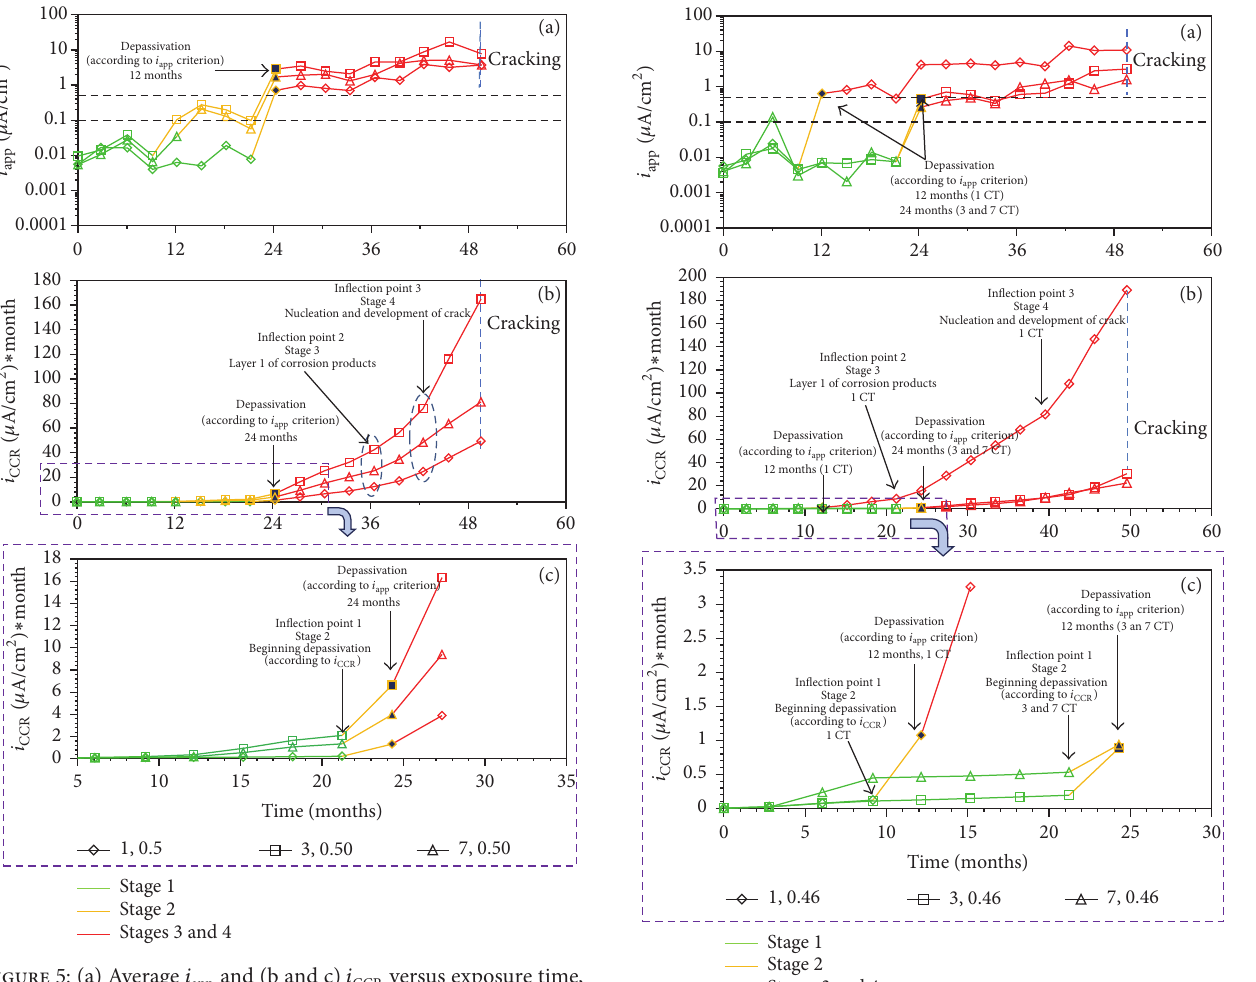
Figure 5: (a) Average 𝑖 app and (b and c) 𝑖 CCR versus exposure time, w/c ratio = 0.50, and three CTs.